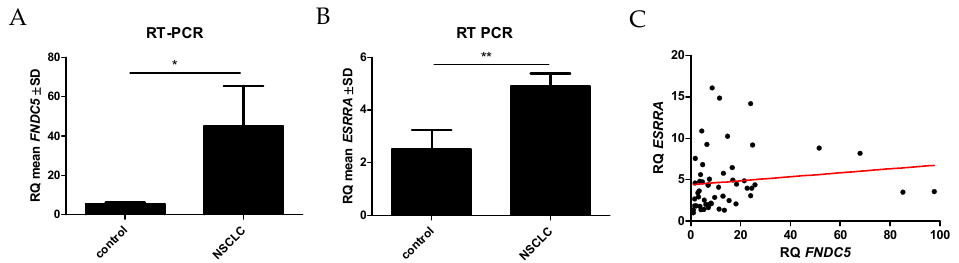
Figure 9. Comparison between control (n = 16) and NSCLCs (n = 56) of FNDC5 mRNA ( A ) and ESRRA mRNA ( B ) expression levels. The moderate positive correlation between mRNA FNDC5 and mRNA ESRRA expression levels in NSCLC patients ( C ), * p ≤ 0.05, ** p ≤ 0.005. 2.8. Influence of Lung Cancer Cells on FNDC5 mRNA Expression Levels in an In Vitro Model The effect of NCI-H1703 and NCI-H522 lung cancer cell lines on the FNDC5 mRNA expression levels in normal fibroblasts of the IMR-90 line was investigated. A slight increase in the expression level of the FNDC5 gene was observed in IMR-90 lung fibroblast cells placed in a 6-well plate with an empty insert (control). The difference was significantly higher only after 72 h, as compared to the expression of FNDC5 mRNA after 24 h (Figure 10A,B). On the other hand, the expression of FNDC5 mRNA in IMR-90 cells was significantly higher after 24 h of co-culture when the cells of NCI-H1703 ( p = 0.0007) (Figure 10C,D) or NCI-H522 ( p = 0.0153) (Figure 9E,F) lines were added to the insert. The highest increase